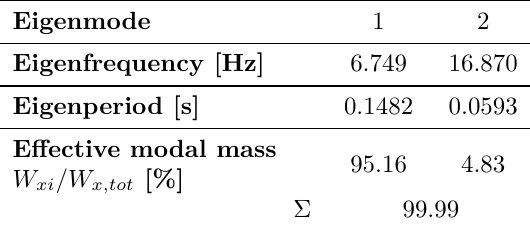
Table 2. Eigenvalue properties of the infinitely stiff